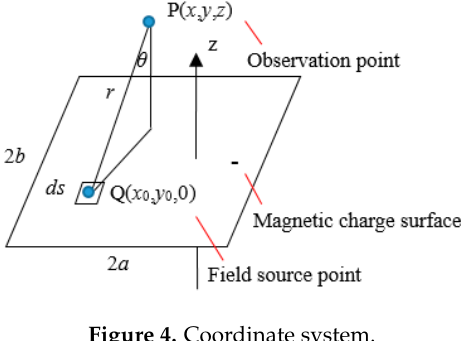
Figure 4. Coordinate system.